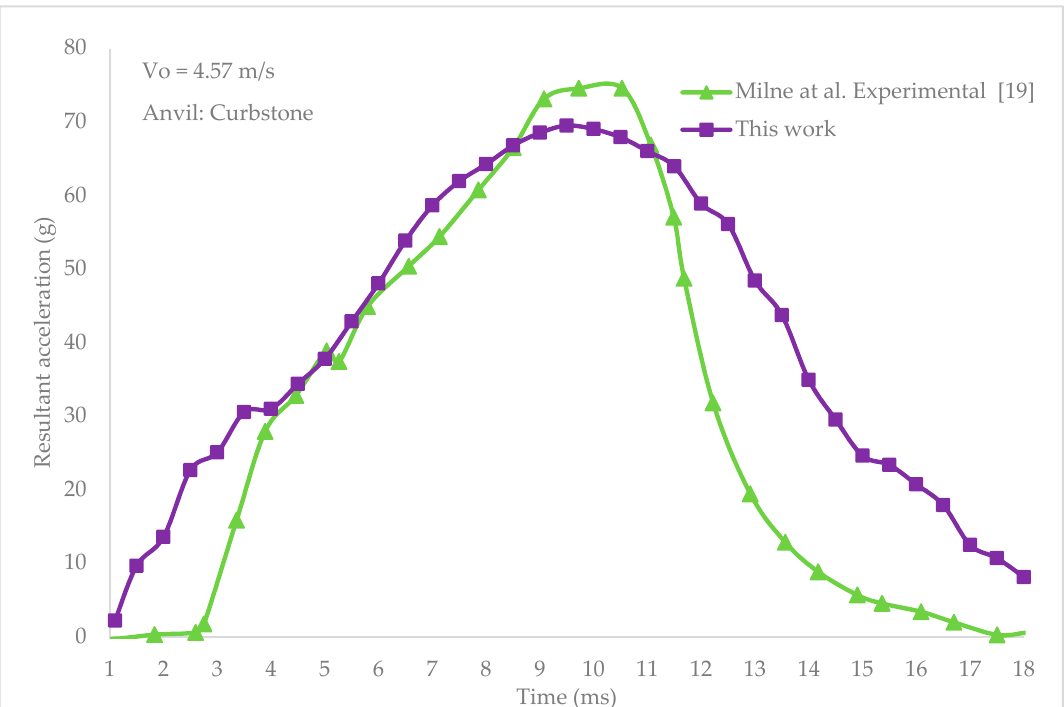
Figure 8. EN 1078 validation of curbstone anvil setup compared to previous research.